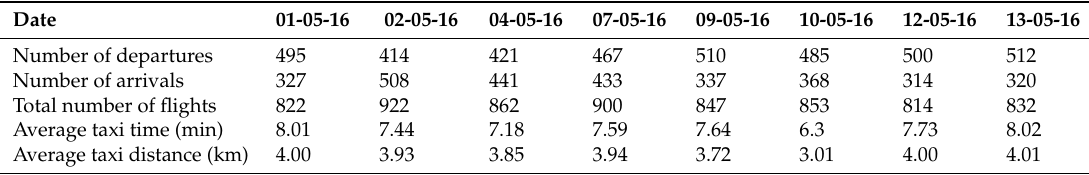
Table 1. The main features of the real-world data used in this